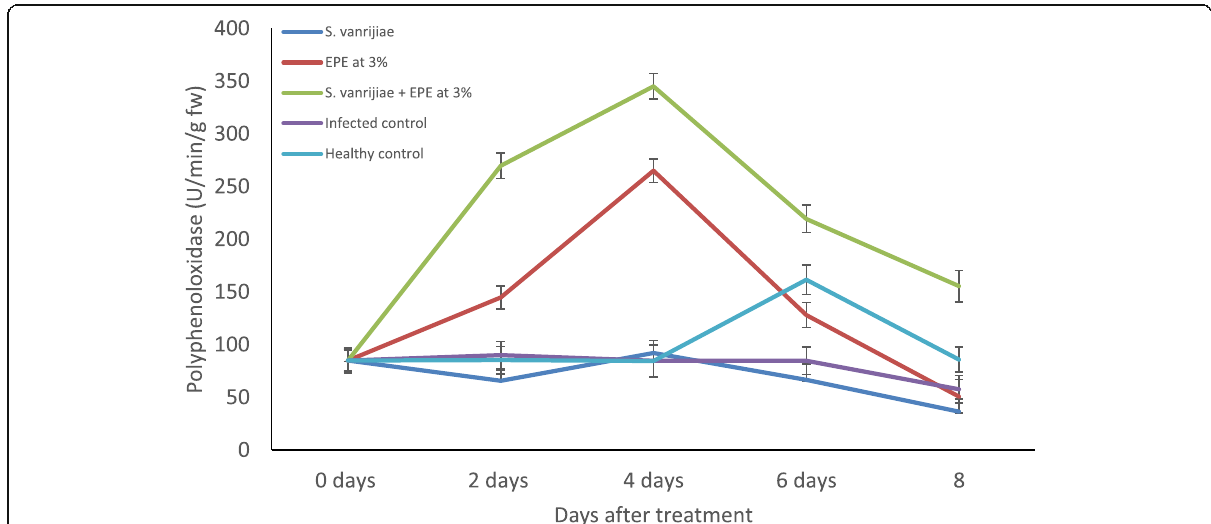
Fig. 4 Time course of polyphenoloxidase activity (U/min/g fw) in extracts from lemon cv seedless limes tissues treated or not with S . vanrijiae and 3% EPE in mixture. All the values are the means of four replicates± SE